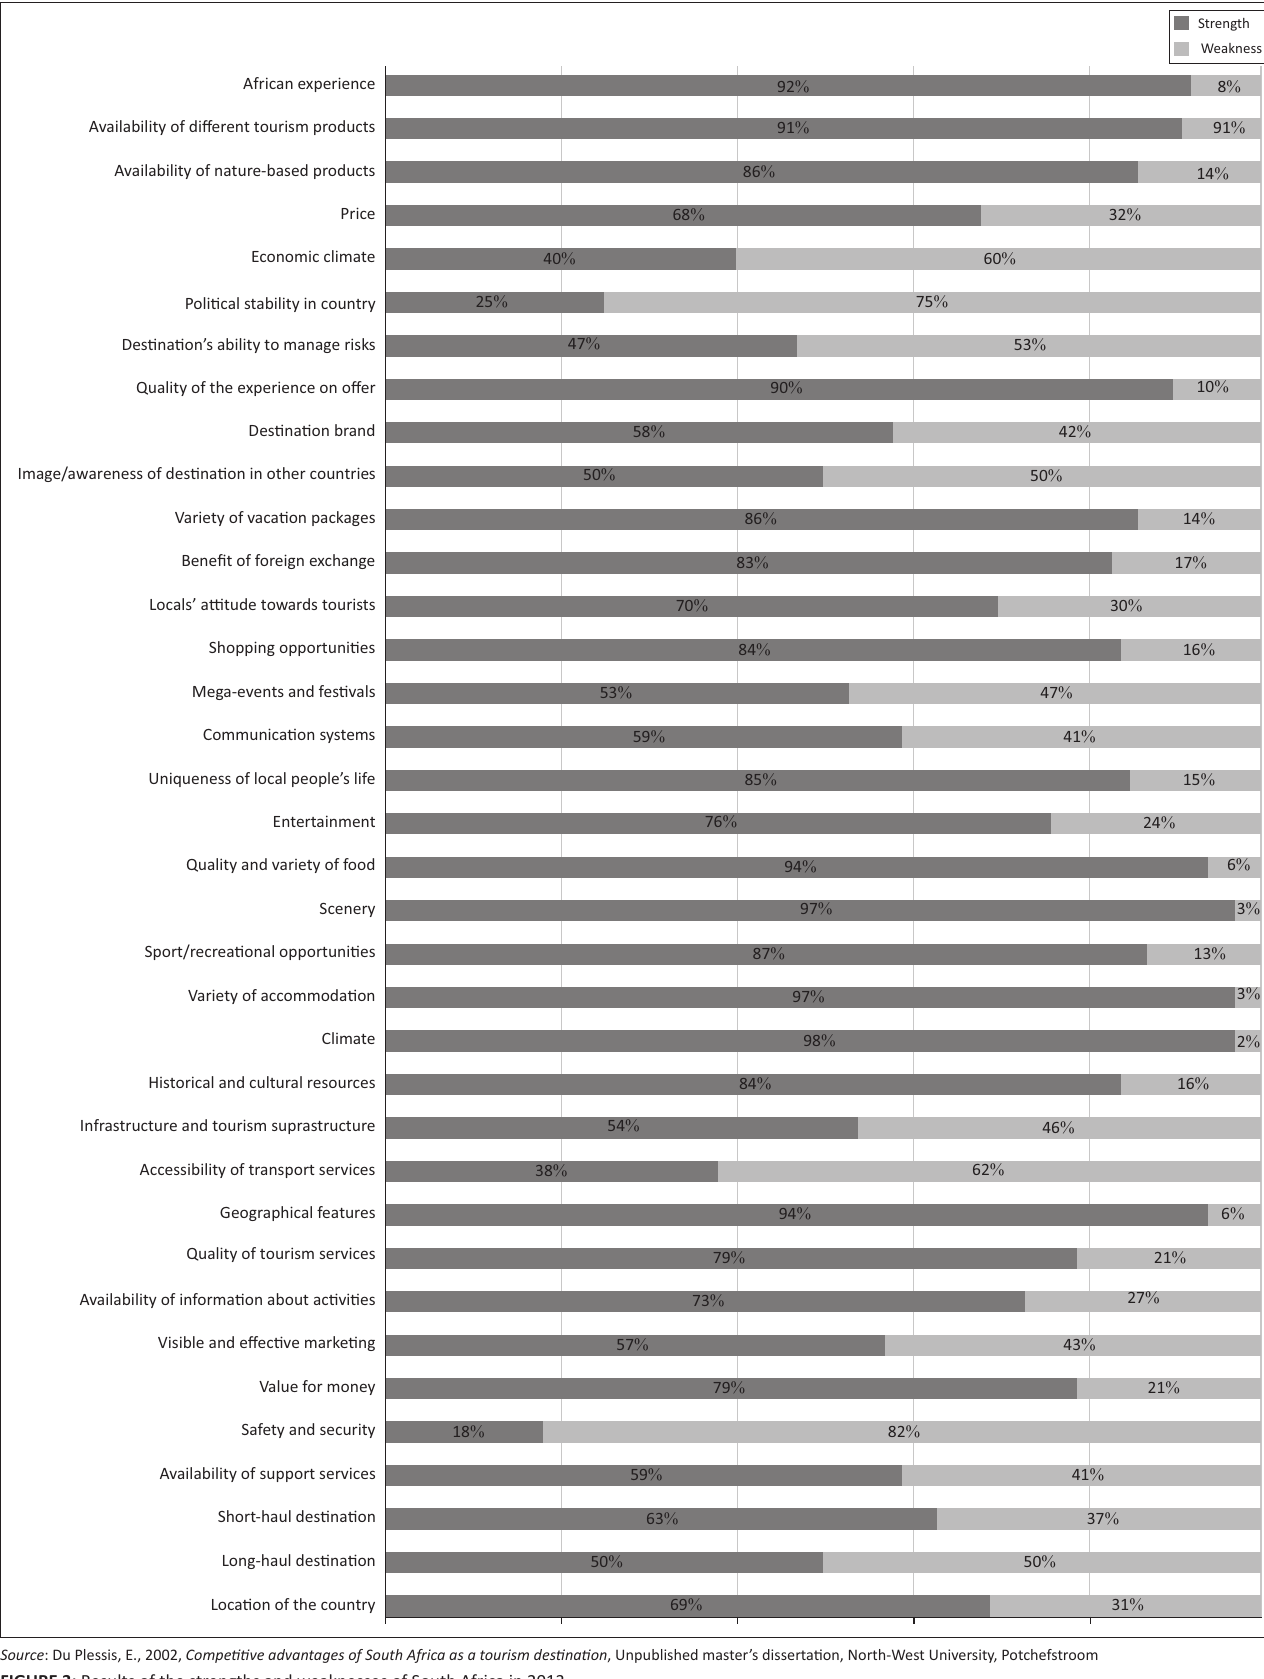
FIGURE 3: Results of the strengths and weaknesses of South Africa in